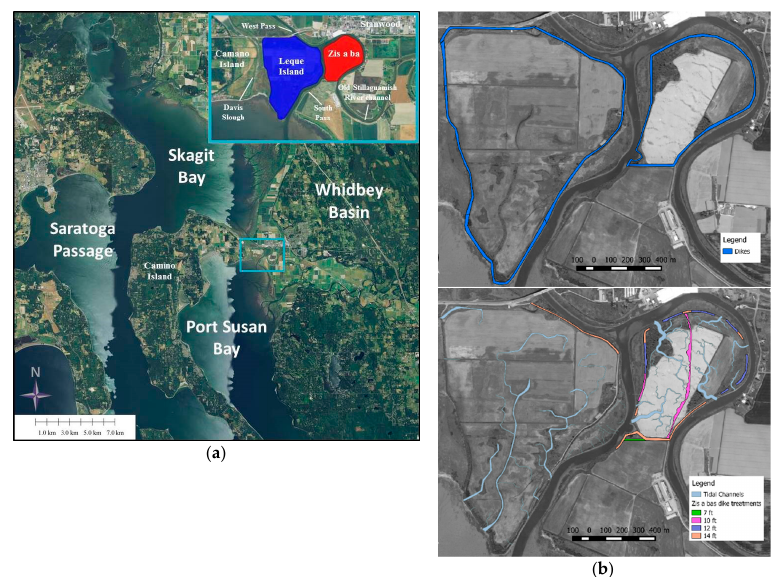
Figure 1. ( a ) Location of the Leque Island and zis a ba sites in Whidbey Basin. ( b ) Schematic representation of ( top ) the baseline scenario and ( bottom ) the preferred restoration alternative scenario.